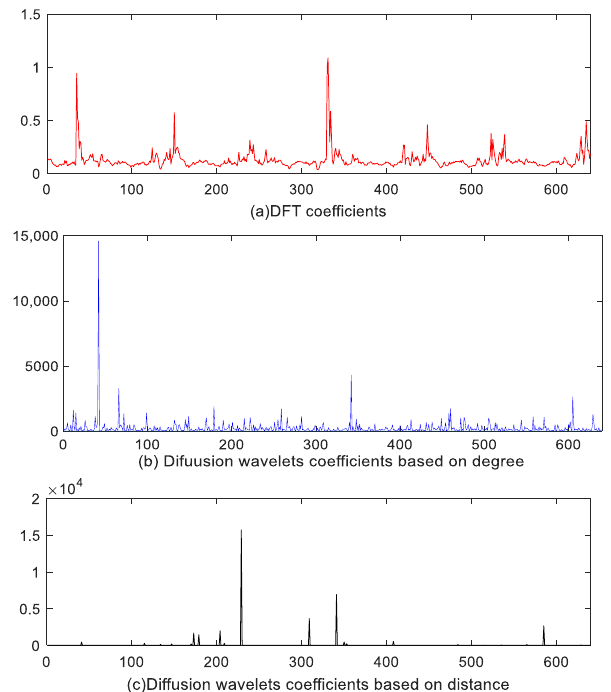
Figure 12. Comparison of different represent basis ( a ) DFT coefficients ( b ) coefficients based on degree ( c ) coefficients based on distance.